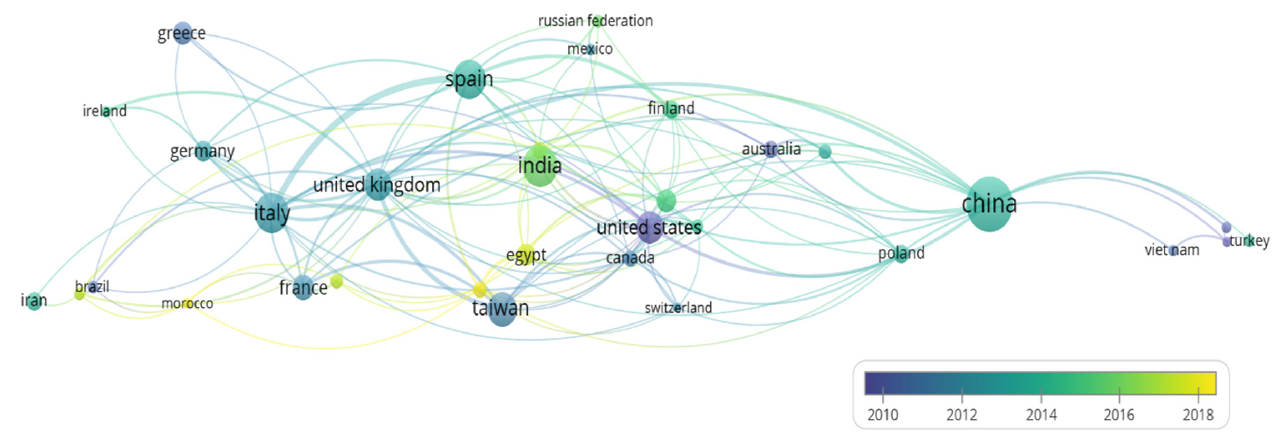
Figure 7. The country map on the ontology- and fuzzy-based IS topic generated from Scopus.